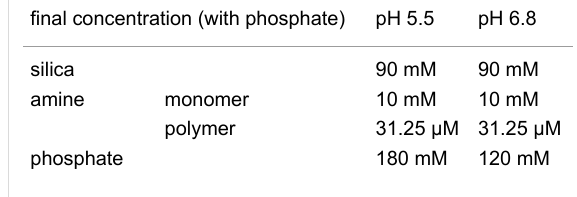
Table 6: Final concentration of turbidity measurements with phos-